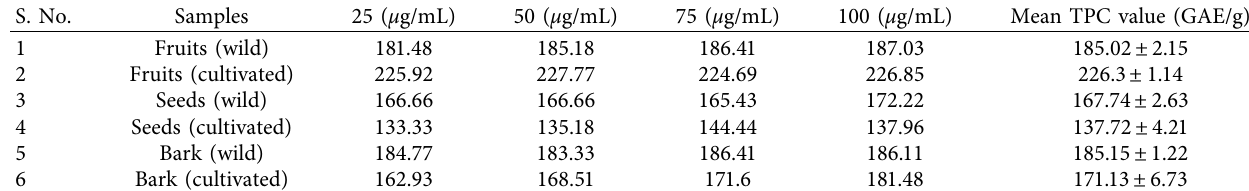
Table 1: Total phenolic contents (TPC) in different extracts of Z . armatum